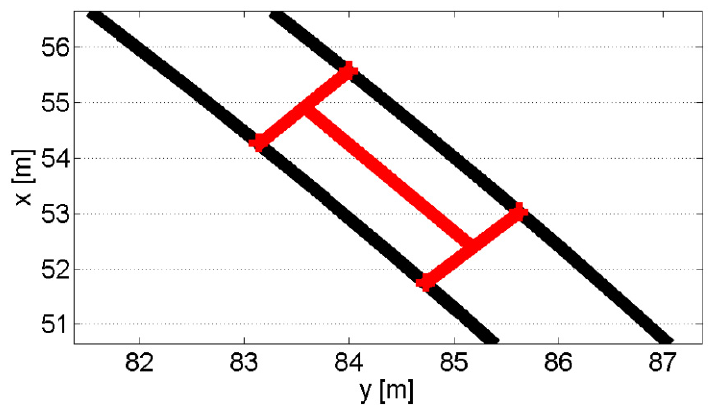
Figure 18. Graphic illustration of the boogie’s path along an arc.